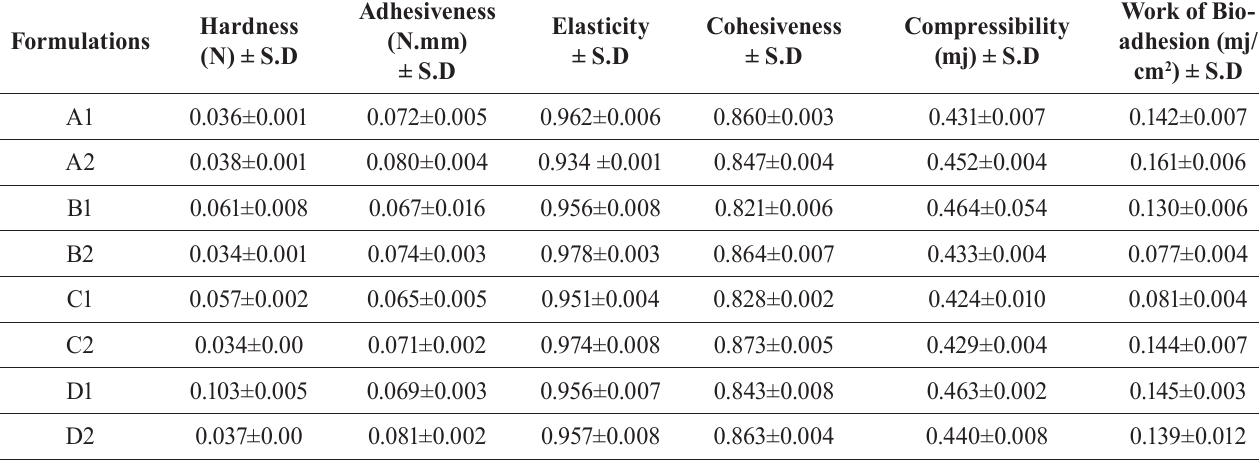
TABLE III - Mechanical and bioadhesive properties of hydrogel formulations (n=3). The mechanical and bioadhesive characterizations of hydrogels were measured when the hydrogels reached room temperature